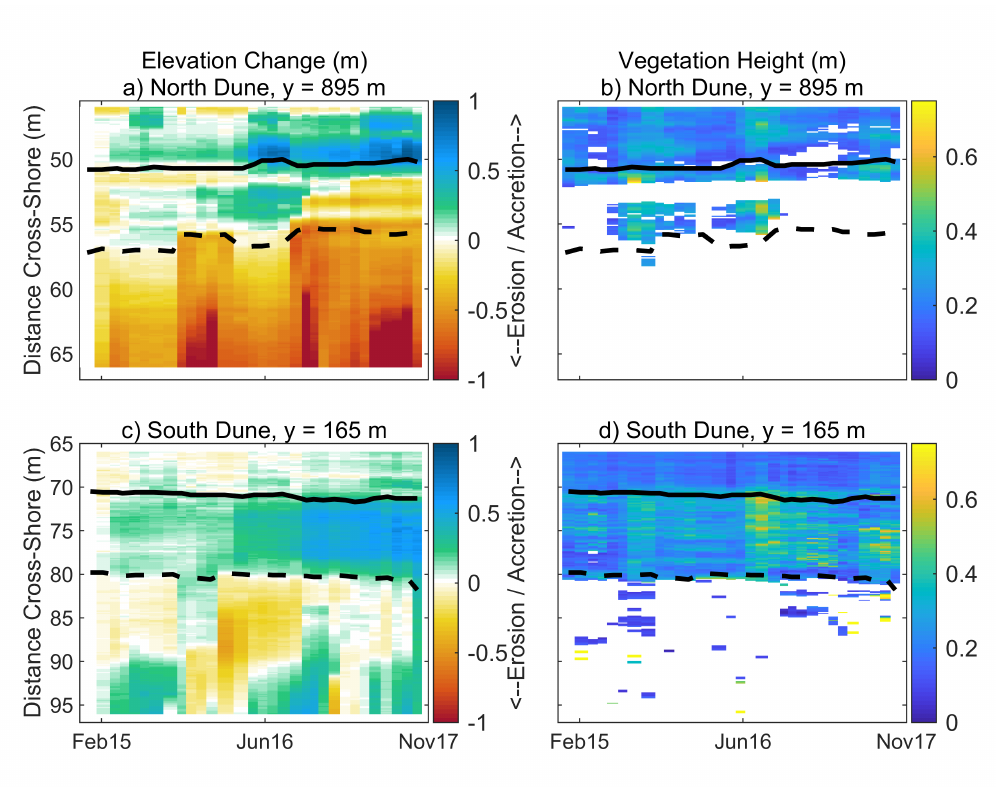
Figure 10. Temporal variability in dune growth and vegetation height at two example transects. ( a , c ) Elevation change since the first survey (colors) at each cross-shore position versus time at y = 895 m ( a , North site) and y = 165 m ( c , South site), respectively. ( b , d ) Vegetation height (colors) through time along the same transects for the north and south sites, respectively. The black solid and dashed lines show the cross-shore position of the dune crest, x c , and 4 m contour, x 4 m ,